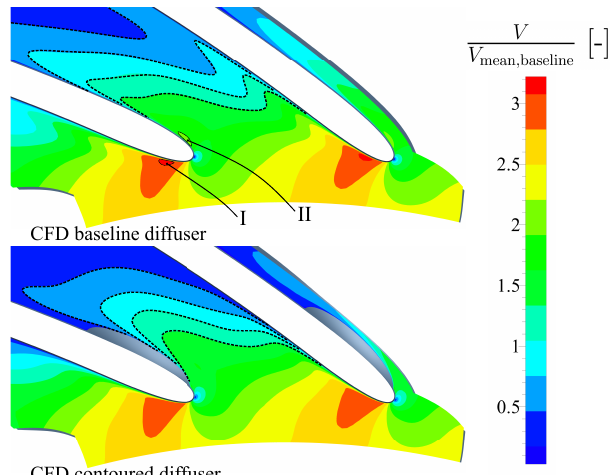
Figure 10. Distribution of normalized magnitude of absolute velocity at 5% channel height at Mu 2 = 1.16 at operating point near the stability limit.